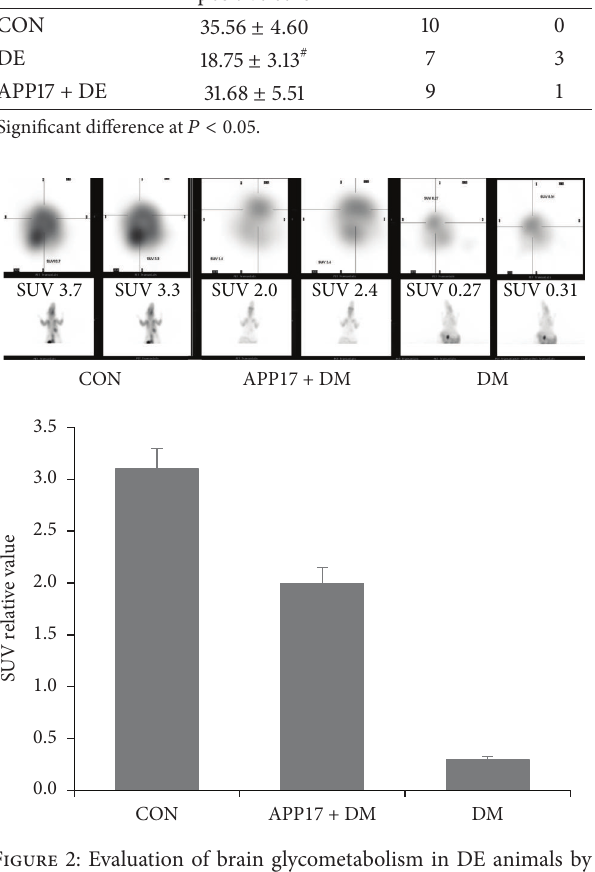
Figure 2: Evaluation of brain glycometabolism in DE animals by PET/CT.